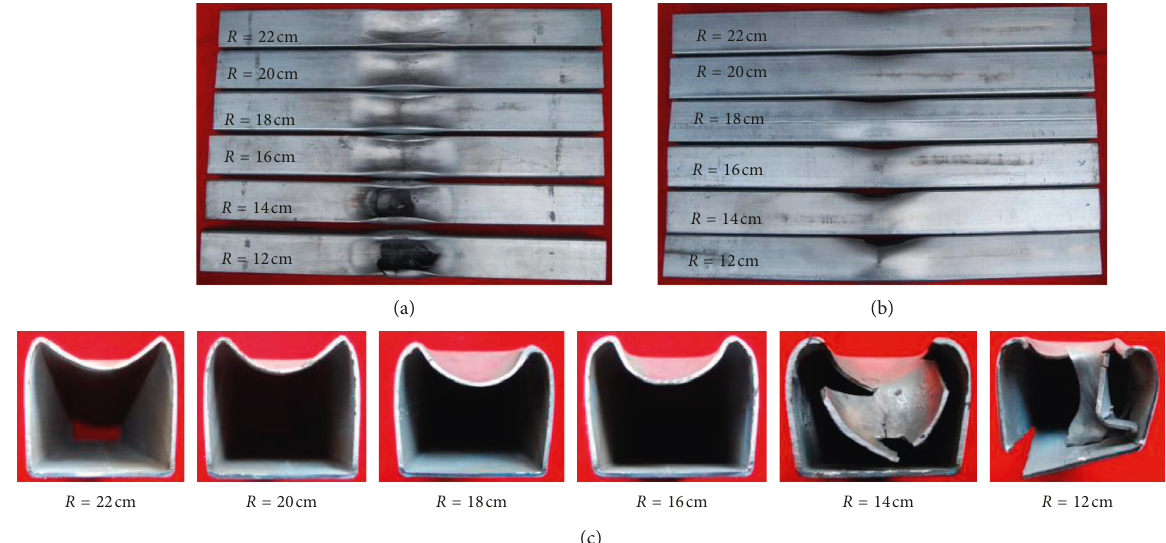
Figure 13: Damage of square tubes with a thickness of 3.5mm at different stand-off distances. (a) Planform view. (b) Side view. (c) Cross section.